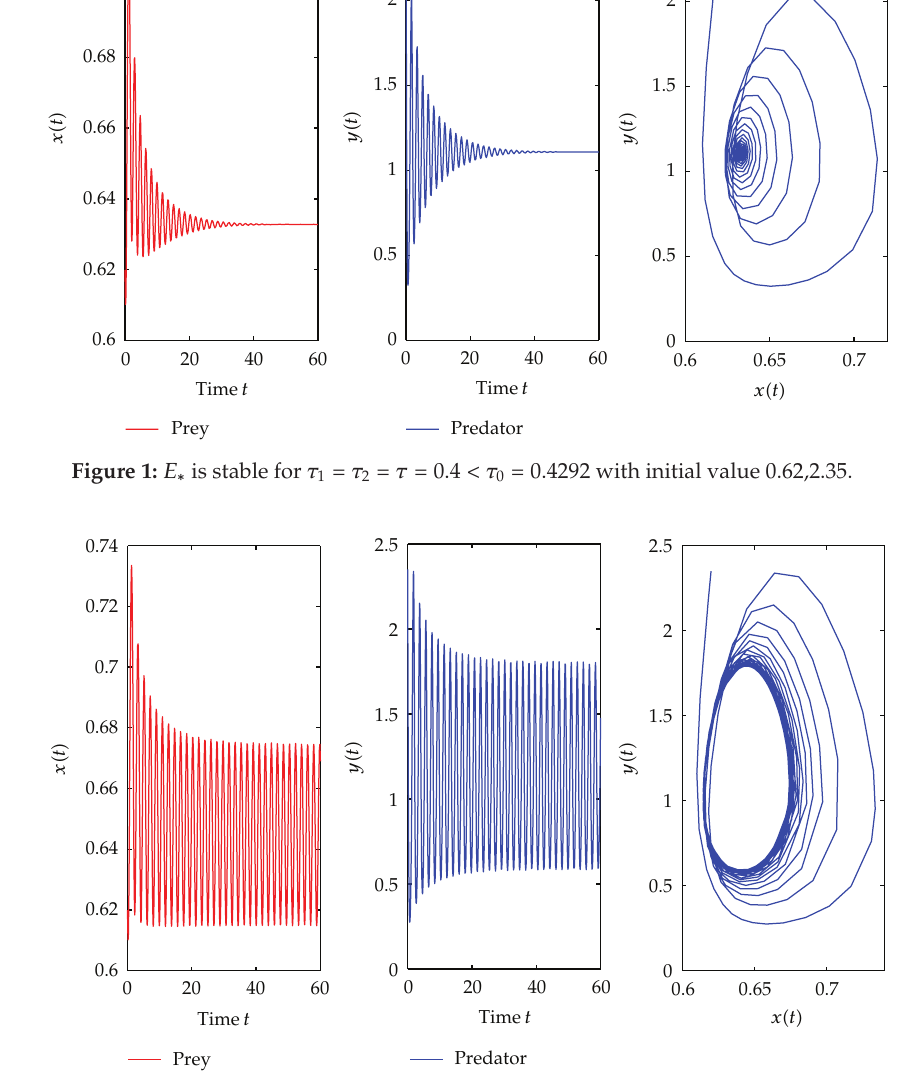
Figure 2: E ∗ is unstable for τ 1 (cid:5) τ 2 (cid:5) τ (cid:5) 0 . 44 > τ 0 (cid:5) 0 . 4292 with initial value